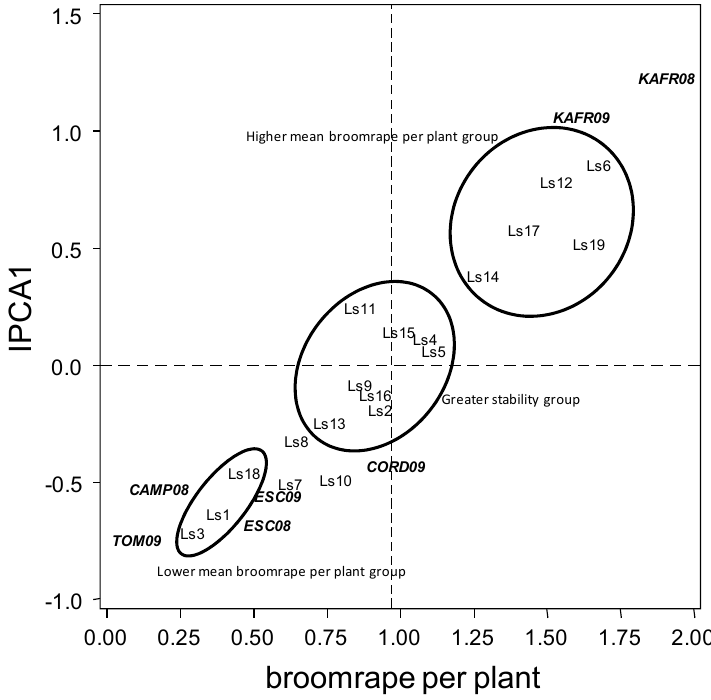
Figure 4. AMMI1 Biplot display for broomrape per plant and IPCA 1 scores of the 19 grass pea lines tested across seven environments. Vertical line at the centre of biplot is the general grand mean.